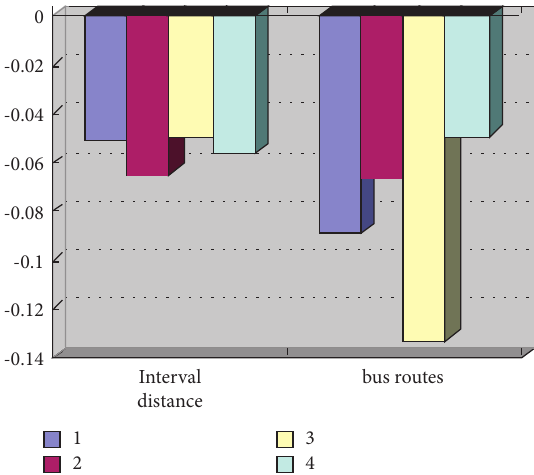
Figure 5: Fluctuation threshold of influencing factor η parameter.